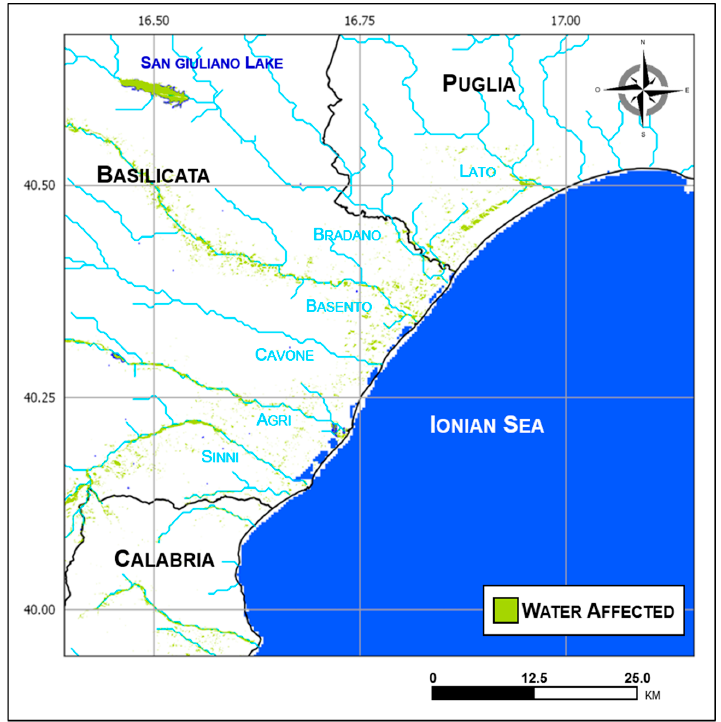
Figure 2. In green, the pixels of the Landsat 7 ETM+ image, shown in Figure 1, recognized as water affected are depicted (see text).